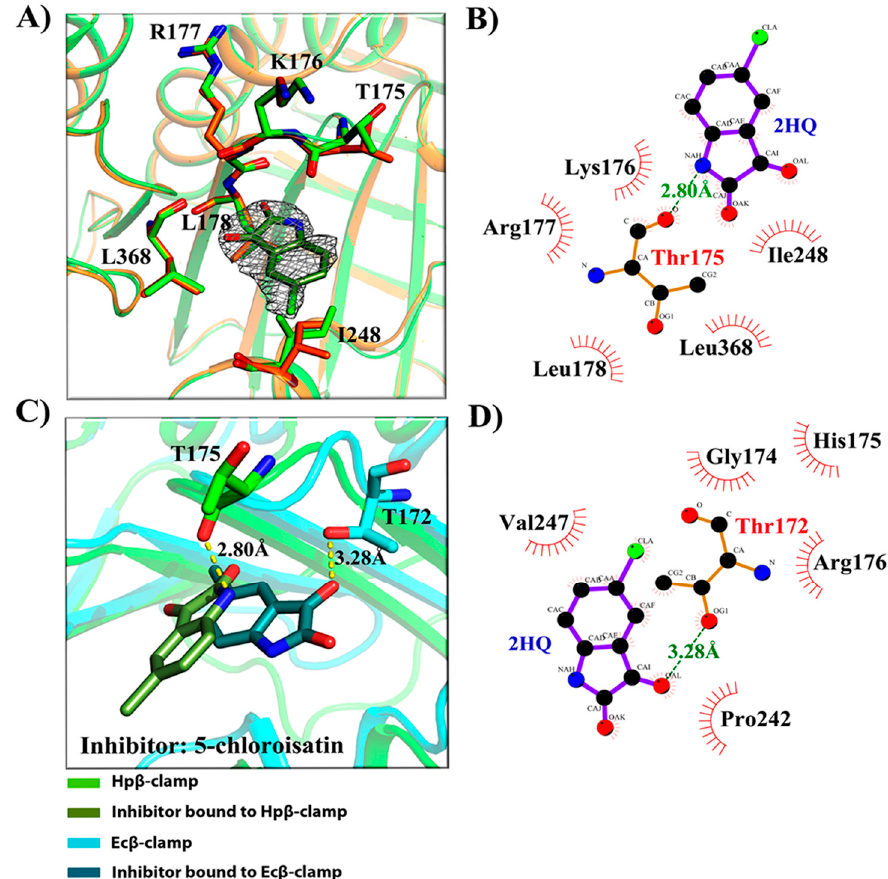
Figure 2. 5-chloroisatin interaction with Hp β -clamp. ( A ) 2Fo-Fc map, contoured at 1 σ , of 5-chloroisatin bound to Hp β -clamp (PDB ID: 5G4Q). The alignment of the structure of the complex (green) with that of the native (orange) did not yield significant differences in the orientation of interacting residues except for I248; ( B ) Ligplot of the Hp β -clamp structure near the bound 5-chloroisatin, showing the predominantly hydrophobic interactions between the protein and the inhibitor. T173 of Hp β -clamp did form an H-bond with the inhibitor molecule; ( C ) Structural alignment of Hp β -clamp (green) and Ec β -clamp (cyan) complex with ligand 5-chloroisatin. T172 of Ec β -clamp makes H-bond with ligand while T175 of Hp β -clamp makes H-bond with the ligand (PDB ID: 4N95); ( D ) Ligplot of Ec β -clamp complex with 5-chloroisatin showing the types of interactions between them.